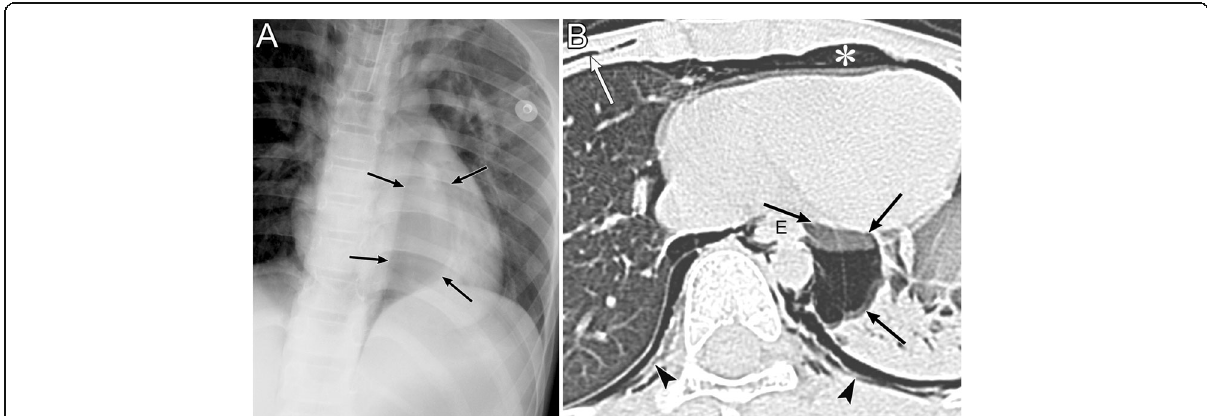
Fig. 18 Air collection in the inferior pulmonary ligament (IPL) of an 8-year-old boy with traumatic tracheal injury. a A supine radiograph shows an oval lucency (black arrows) in the left paramediastinal area, which reflects air collection in the left IPL. b An axial CT image reveals air collection in left IPL (black arrows) because air collects along the mediastinum at the level of the esophagus (E). Pneumomediastinum (white asterisk), intrathoracic extrapleural space air collection (black arrowheads), and subcutaneous emphysema (white arrow) are also evident